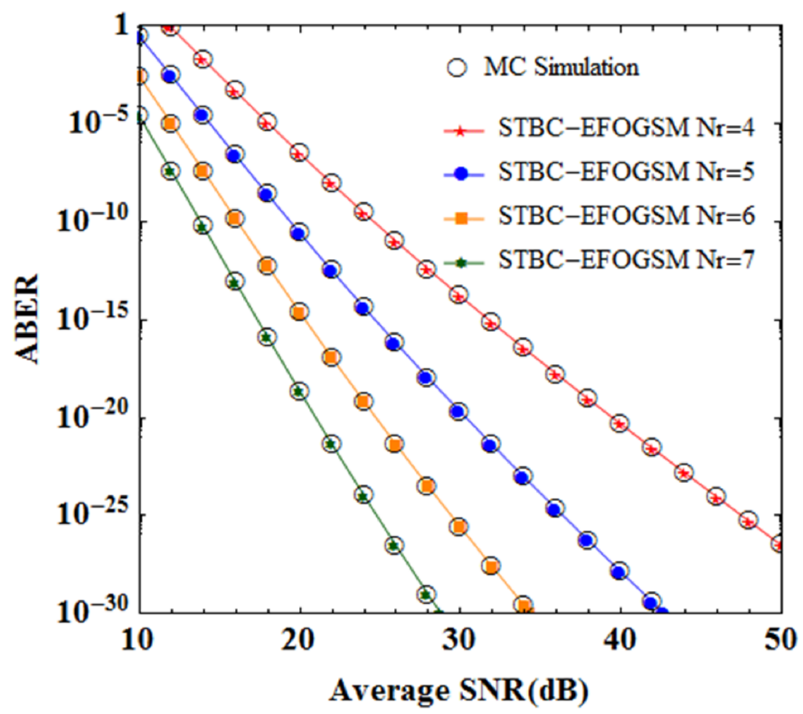
Figure 6. ABER comparison of the GSTBC-EFOGSM R = 0.75 system with different receiver photode- tectors N r